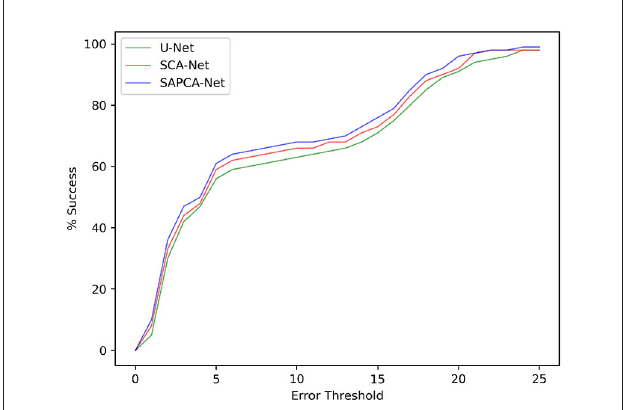
FIGURE6 The registration success with different error thresholds for the model with different network settings on FIRE dataset.